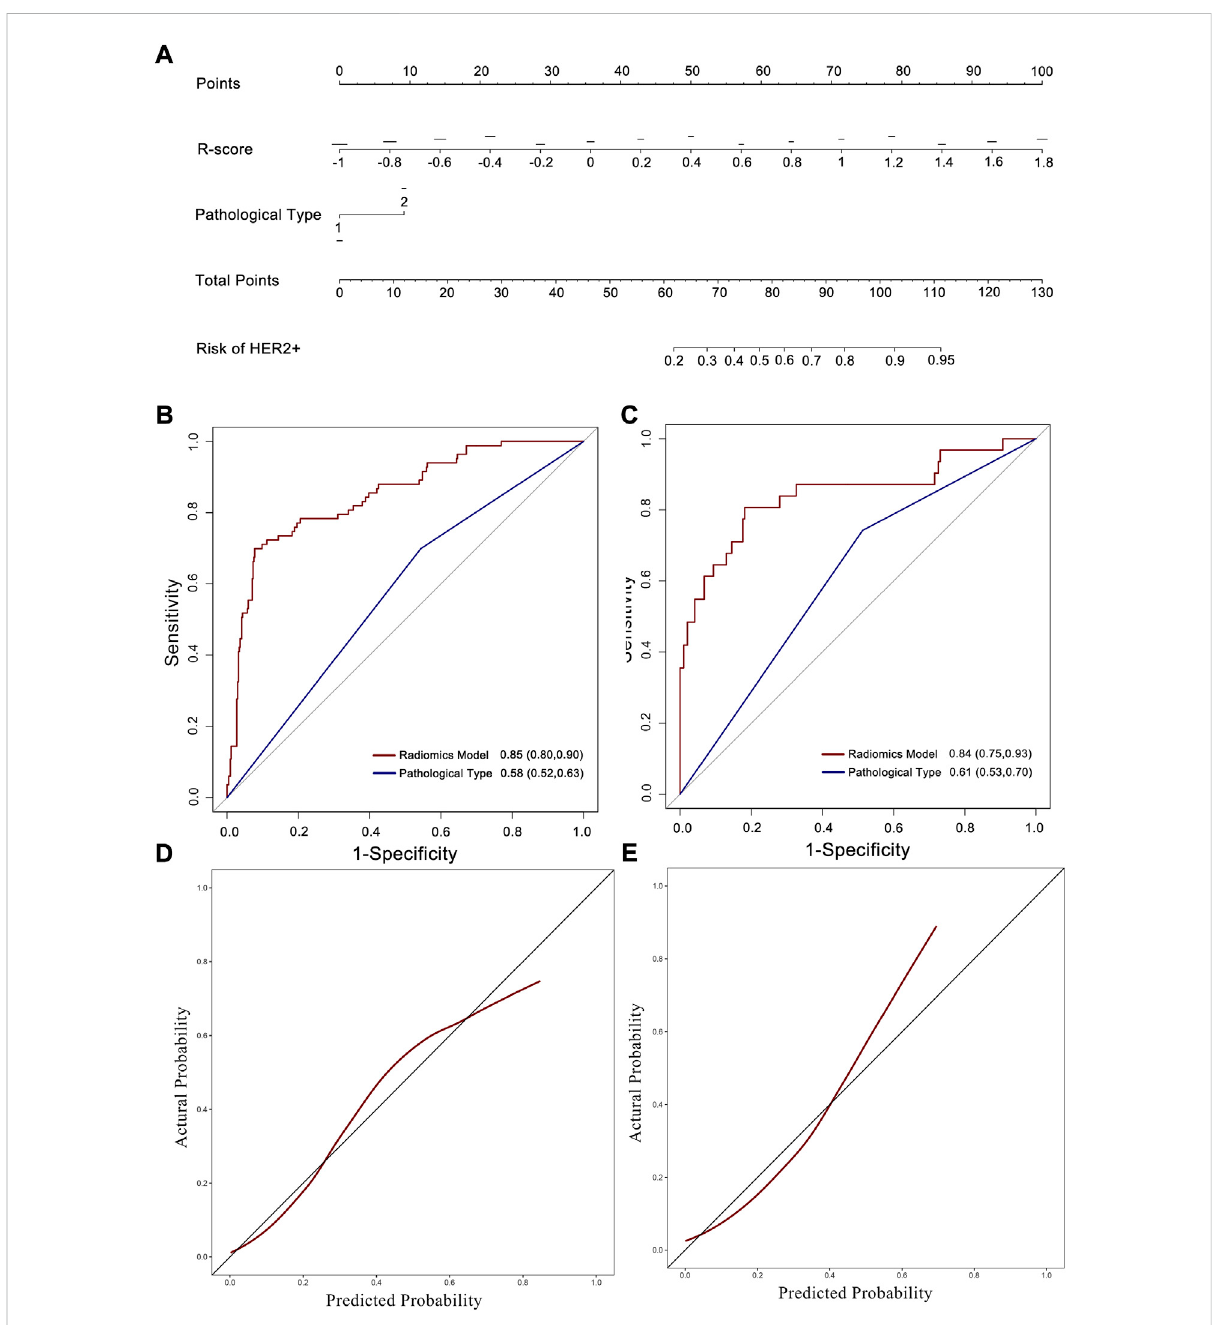
FIGURE 4 Nomogram developed with ROC and calibration curves. (A) A radiomics nomogram was developed in the training set with radiomics signature and pathological type incorporated. ROC curves of the radiomics nomogram and pathological type for the prediction of HER2 status in the training (B) , and testing (C) sets. Calibration curves of the nomogram in the training (D) , and testing (E)